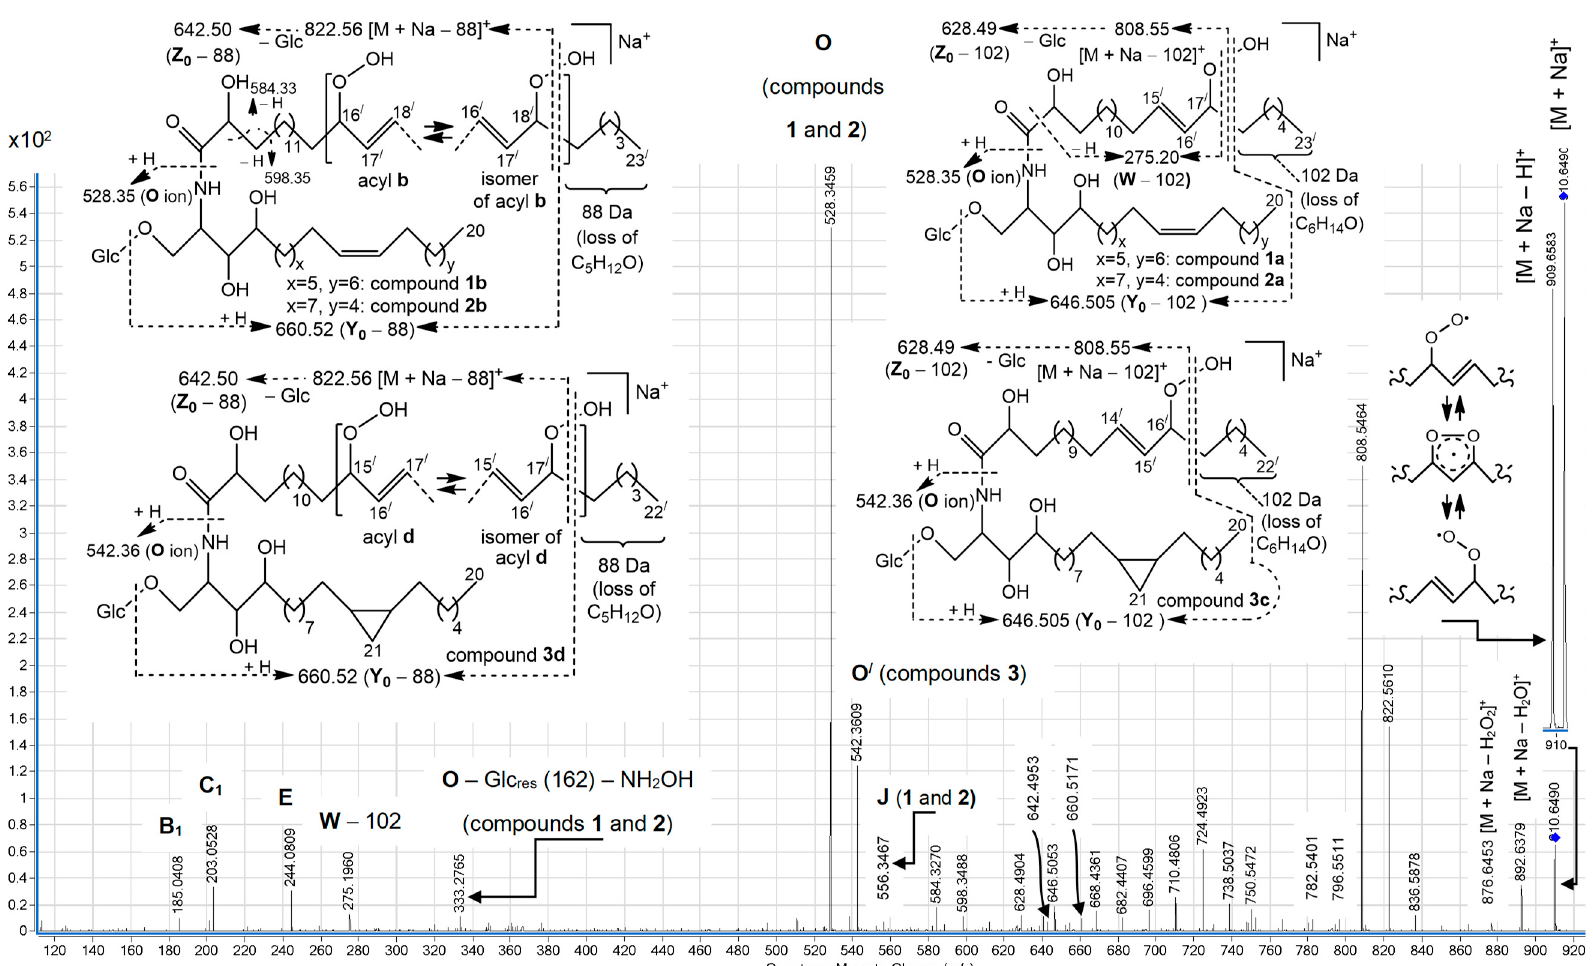
Figure 2. (+)ESI-MS/MS spectrum of [M + Na] + ion of isomeric allylic hydroperoxides 1a , 1b , 2a , 2b , 3c , and 3d .